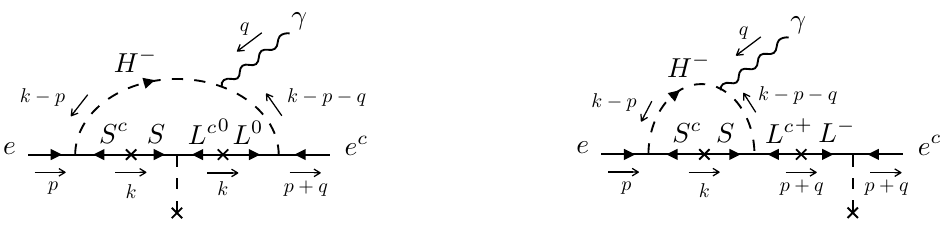
Figure 4 . One-loop diagrams providing the (a priori) leading contribution to the electromagnetic dipole moment of charged SM leptons in the model of eq. (2.6) with Y 0 proportional to the combination of couplings Y